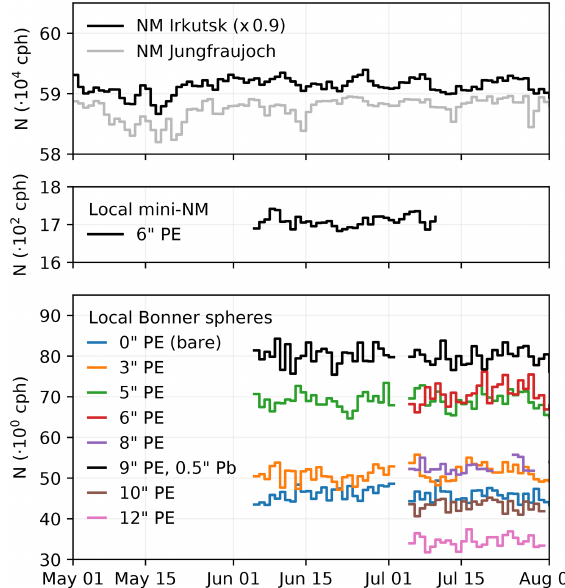
Figure 5. Neutron count rate N for different detector types: the re- mote neutron monitors at Jungfraujoch and Irkutsk, the local mini- NM, and the local Bonner spheres. Each instrument is equipped with different PE or lead shields to adjust the detection sensitivity towards different neutron